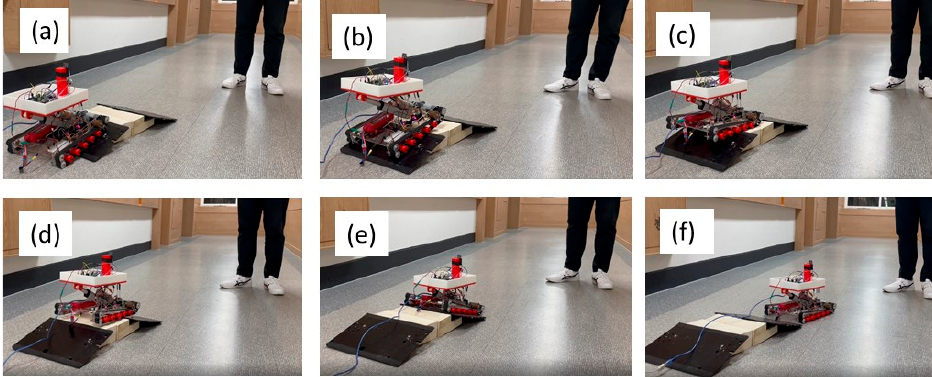
Figure 14. Video clip capture images during the experiments; Case I: clip order: ( a – f ).